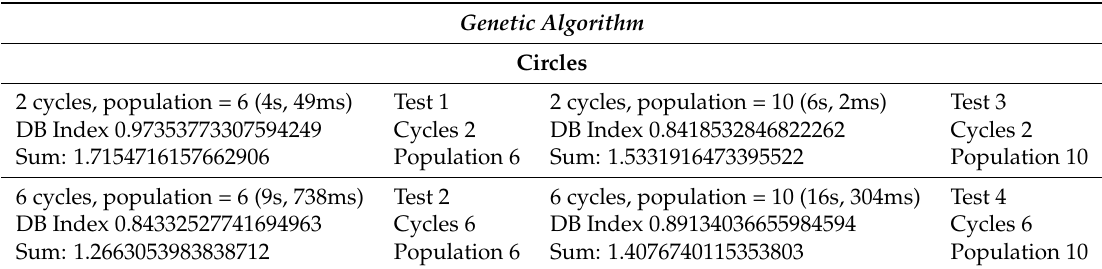
Table 5. The results of performed tests for the genetic algorithm (GA) with manipulations. Genetic Algorithm